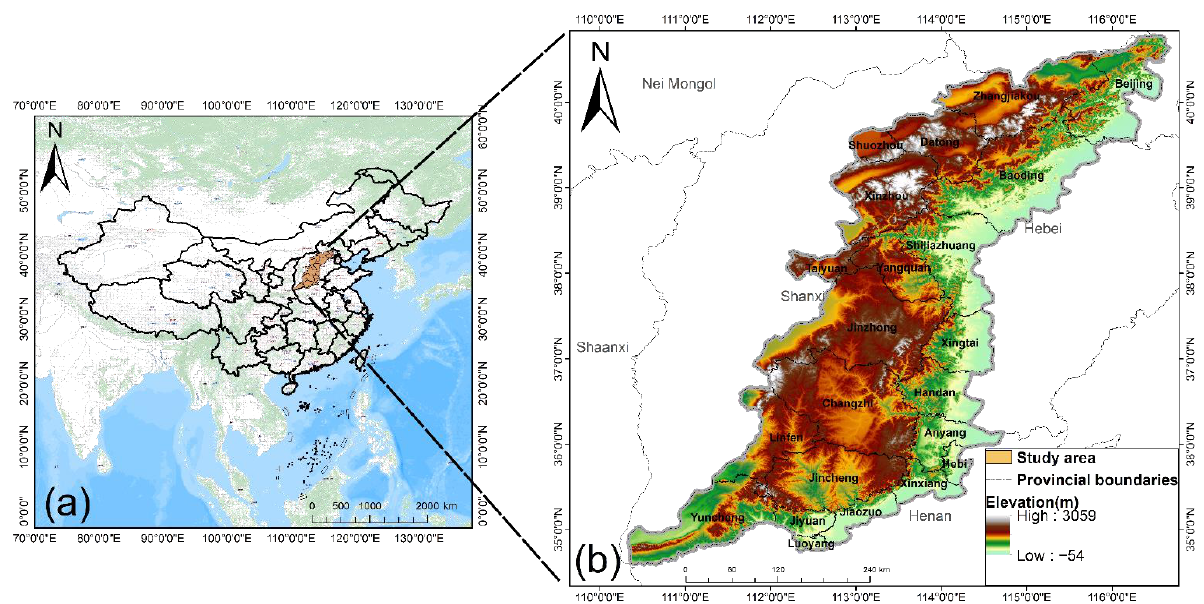
Figure 1. The geographical location of Taihang Mountains: ( a ) location of Taihang Mountains in China; ( b ) location of Taihang Mountains. (China Map from the website of China Standard Map Service (http://bzdt.ch.mnr.gov.cn/ (accessed on 28 January 2022)), the figure number is GS (2019) 1822). Table 1. Carbon density of various land use types in the Taihang Mountains (t · km − 2 ). Type C above C below C soil C dead farmland 2.19 0.42 90.16 grassland 38.99